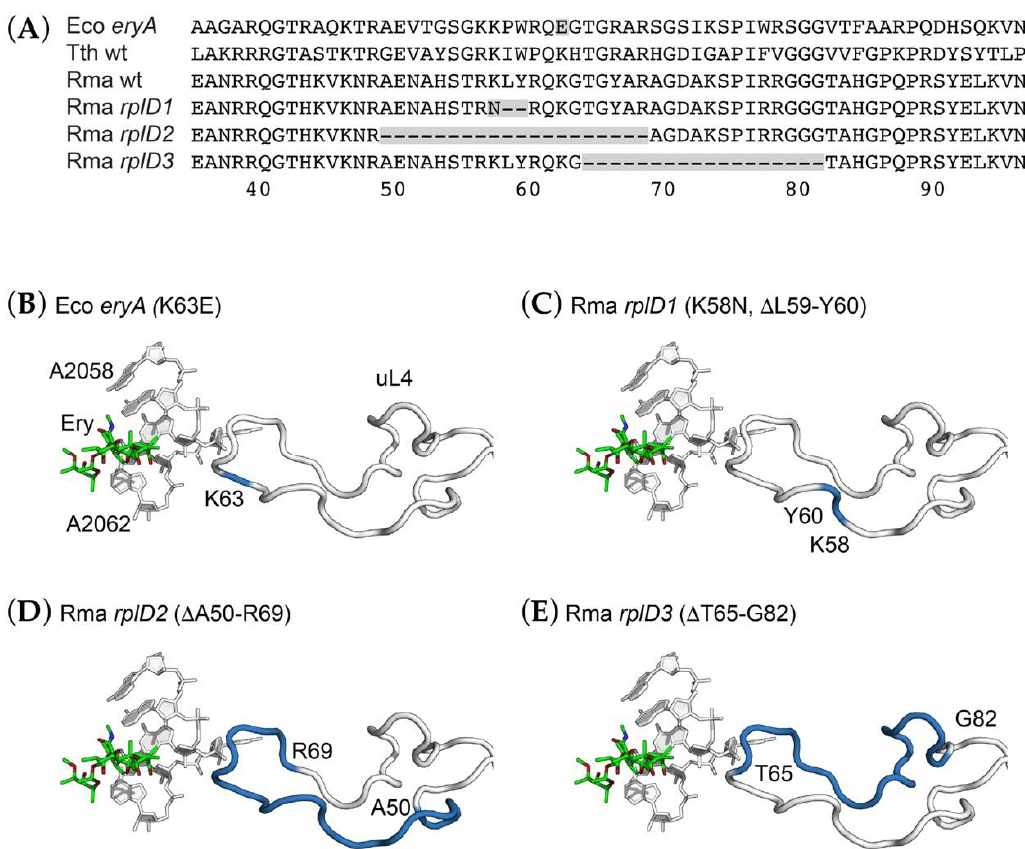
Figure 4. Erythromycin-resistance mutations affecting ribosomal protein uL4. ( A ) Partial sequence alignment of ribosomal proteins uL4 from Escherichia coli (Eco), Thermus thermophilus (Tth), and Rhodothermus marinus (Rma) highlighting sights of erythromycin-resistance mutations. ( B – E ) Three-dimensional structure showing the interaction with the extended loop of ribosomal protein uL4 and the erythromycin binding site of 23S rRNA, illustrated using the Thermus thermophilus 70S ribosome-erythromycin complex (pdb entry 6nd6). For clarity, only several 23S rRNA nucleotides and the extended loops of uL4 are shown. Residues mutated are colored blue. ( B ) The eryA K63E mutation from E. coli . ( C ) The R. marinus rplD1 (K58N, ∆ L59-Y60) mutation. ( D ) The R. marinus rplD2 ( ∆ A50-R69) mutation. ( E ) The R. marinus rplD3 ( ∆ T65-G82) mutation. Each of these mutations is expected to perturb RNA conformation in the macrolide binding site.